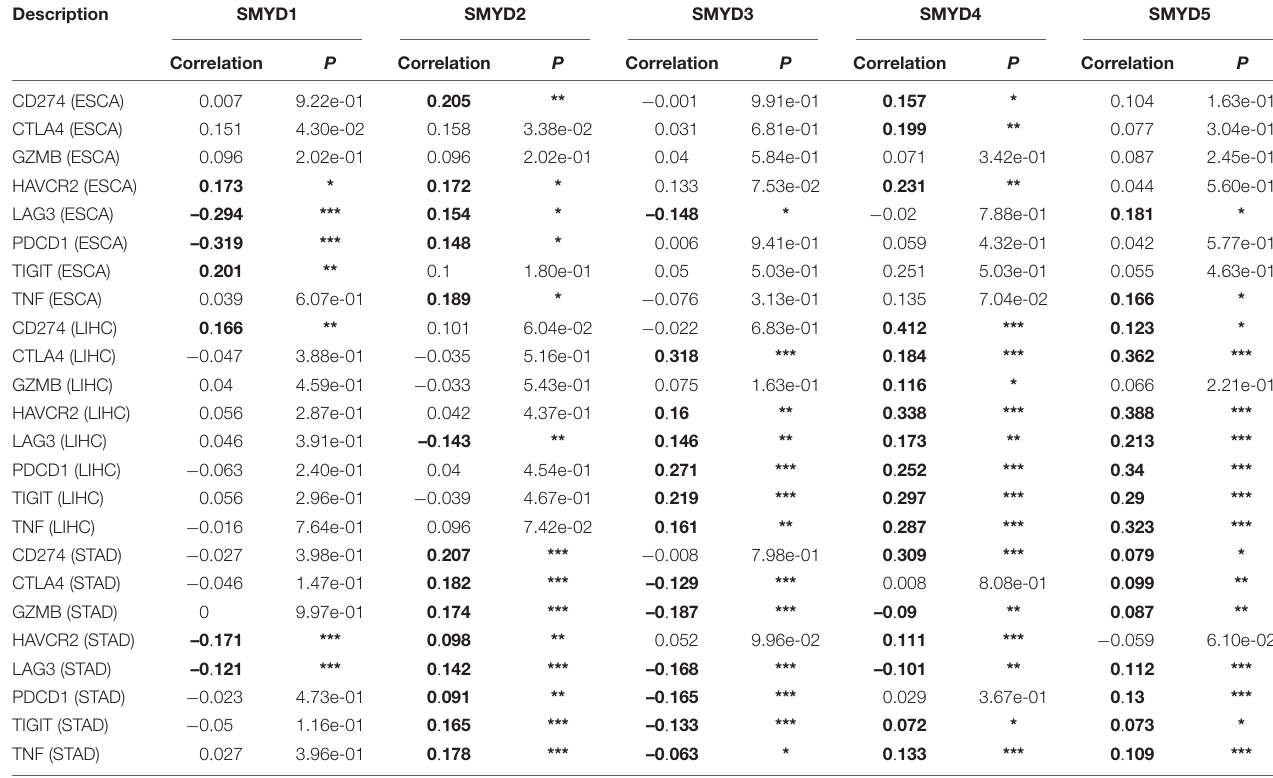
TABLE 5 | Correlation between SMYD members and ESCA, LIH, and STAD immune cell biomarkers (TIMER). Description SMYD1 SMYD2